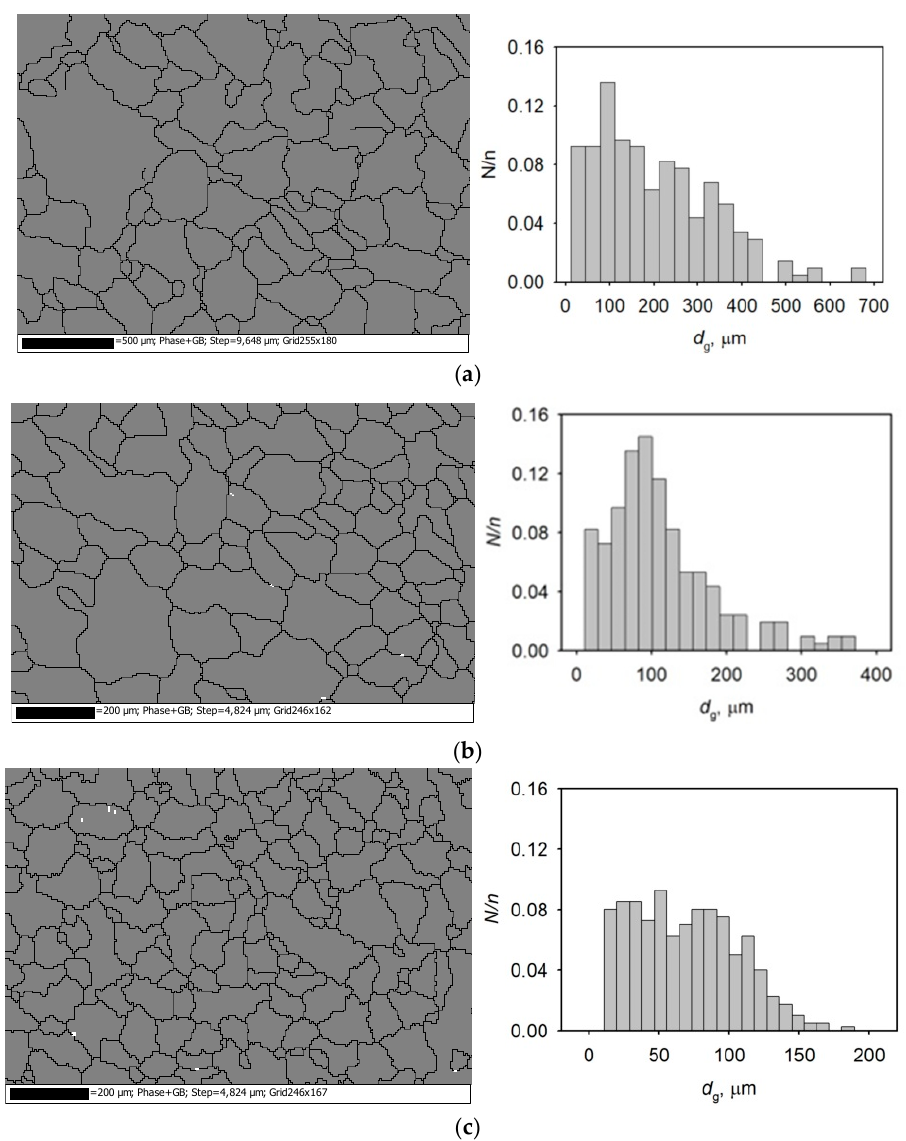
Figure 2. EBSD images of the structure and block diagrams of the grain size distribution in the alloy samples: ( a ) initial state, ( b ) 0.5 wt.% Al 2 O 3 , ( c ) 1 wt.% Al 2 O 3 . d g is the grain size, and N / n is the ratio between the number of measurements and the number of grains of a certain size.